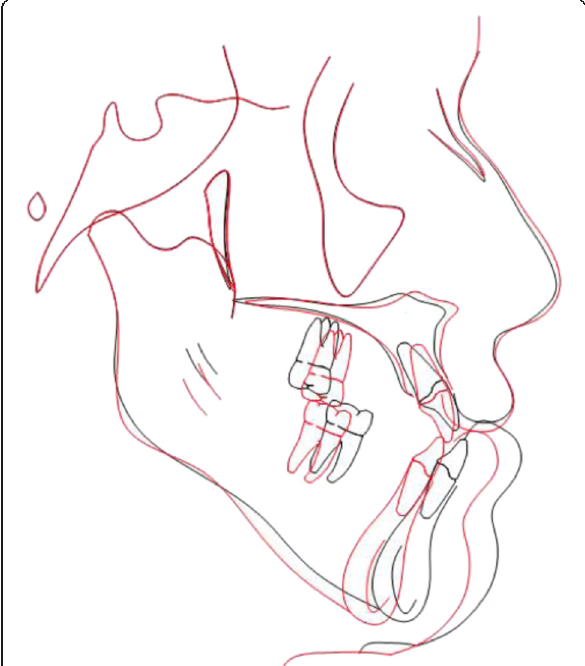
Fig. 3 Superimposition of pre- and post-treatment and traced cephalometric tracing showing advancement of the maxilla and setback of the